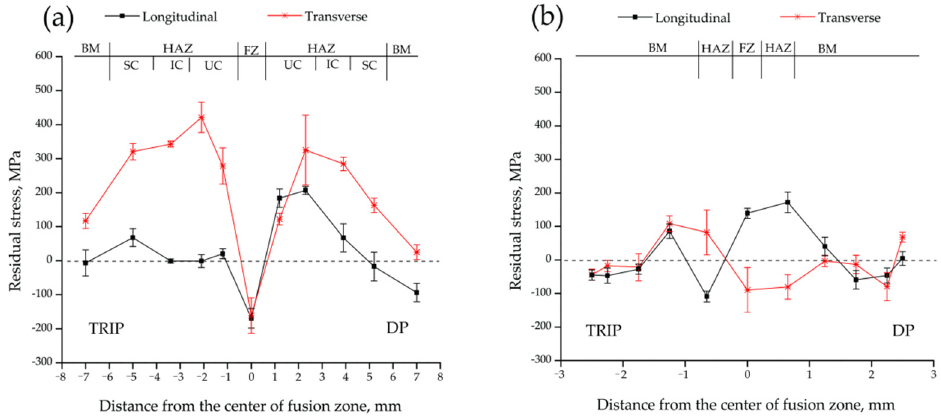
Figure 11. Experimentally measured residual stress profiles along the dissimilar TRIP-DP steel weldment: ( a ) GMAW specimen and ( b ) LBW specimen.